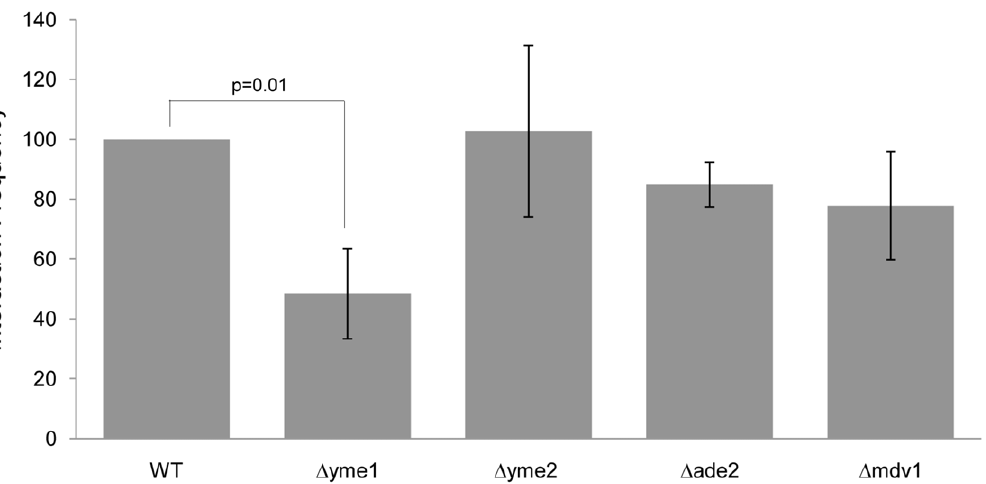
Figure 2. Deletion of yme1 causes a significant reduction in the frequency of the mitochondrial-nuclear COX1 - MSY1 interaction. Interaction frequency between the mitochondrial COX1 and nuclear Msp I fragments was assayed by quantitative 3 C (Methods S1) in wild-type ( S. cerevisiae BY4741), D yme1 (BY4741 D yme1 ), D yme2 (BY4741 D yme2 ), D ade2 (BY4741 D ade2 ) and D mdv1 (BY4741, D mdv1 ) strains. Interaction values were corrected for mitochondrial genome copy number (see Methods) and are expressed as percentages of wild-type (set at 100%) + / 2 standard error of the mean (n=4). Deletion of an unconnected gene ( ade2 ) did not significantly affect interaction frequency. T-tests (paired P(T , =t) one-tail, n=4) were performed to determine the significance of observed variations: wild-type: D yme1 p=0.01; wild-type: D yme2 p=0.377; wild-type: D ade2